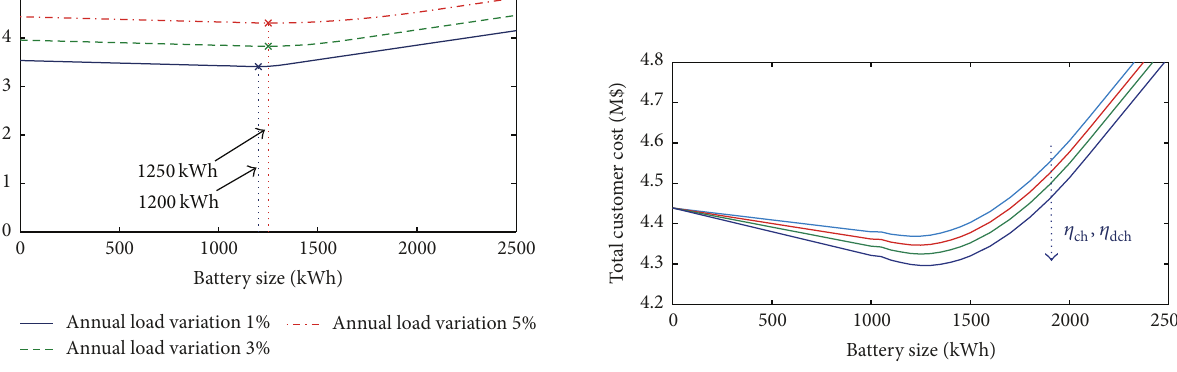
= 95 %, and ch Figure 8: Total customer cost with an annual load variation of 5%, = 95 %, and 𝜂 = 98 % and for different values of 𝛼 and 𝛽 𝜂 ch dch (industrial load).